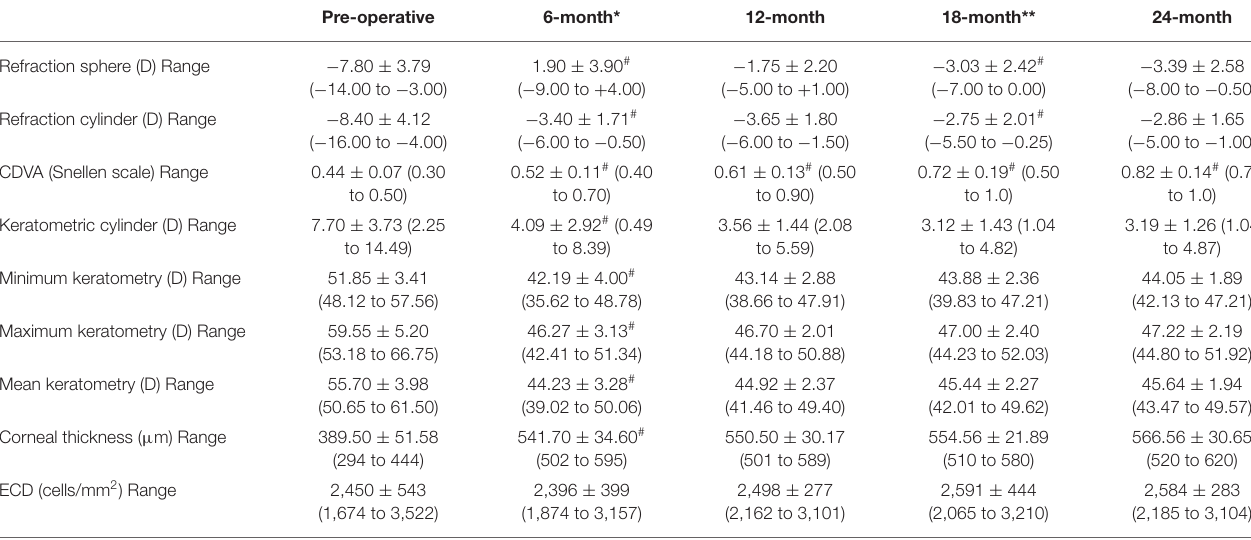
TABLE 2 | Pre-operative and post-operative clinical outcomes.